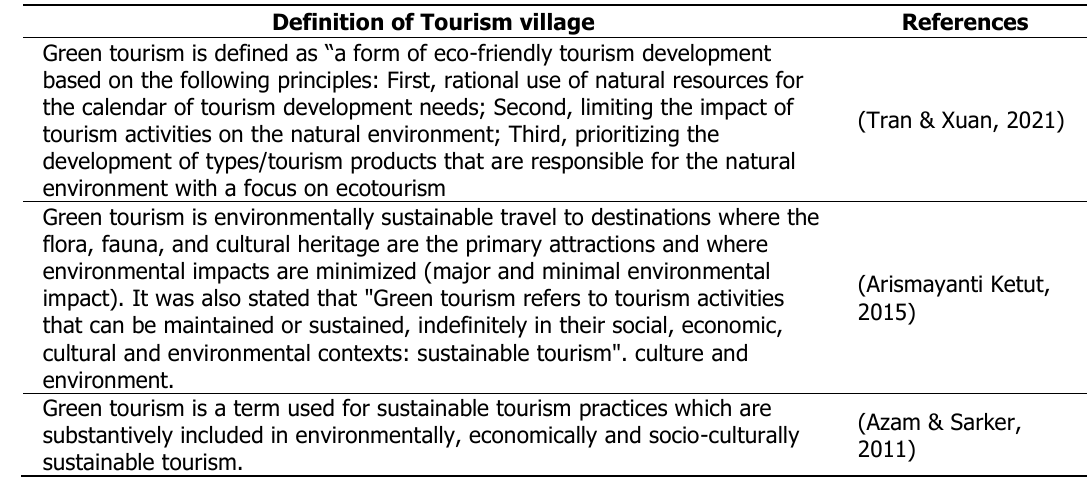
Table 2. Comparison of The Concept of Green Tourism Definition of Tourism